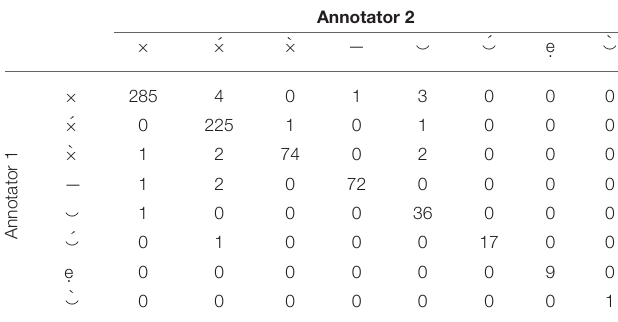
TABLE 2 | Inter-annotator agreement confusion